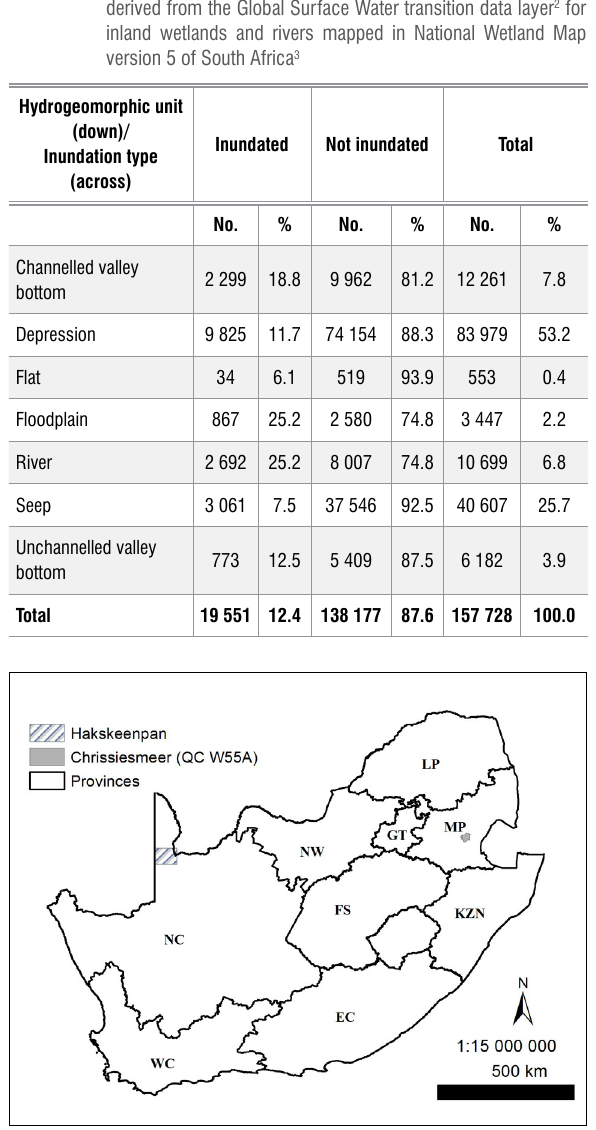
Figure 1: Location of the two study areas, Hakskeenpan and Chrissiesmeer, in the Northern Cape and Mpumalanga Provinces, respectively. See Table 3 for more